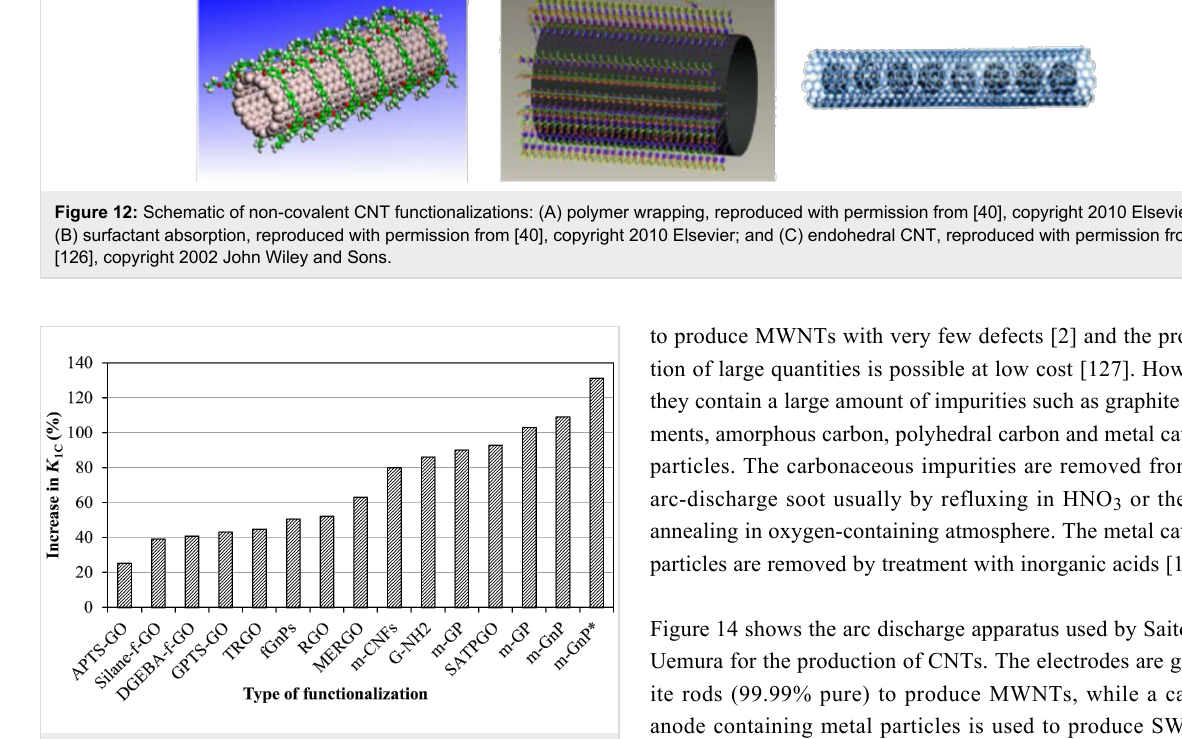
Figure 13: Improvement in K 1C as a function of functionalization method